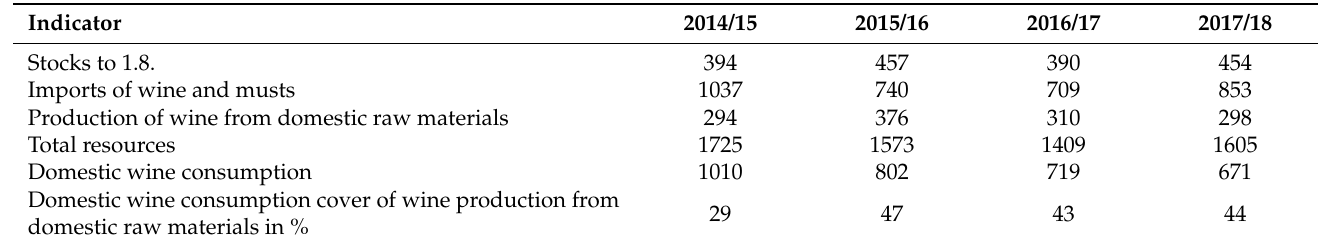
Table 4. Balance of resources and domestic wine consumption in the Slovak Republic (1000 hL).